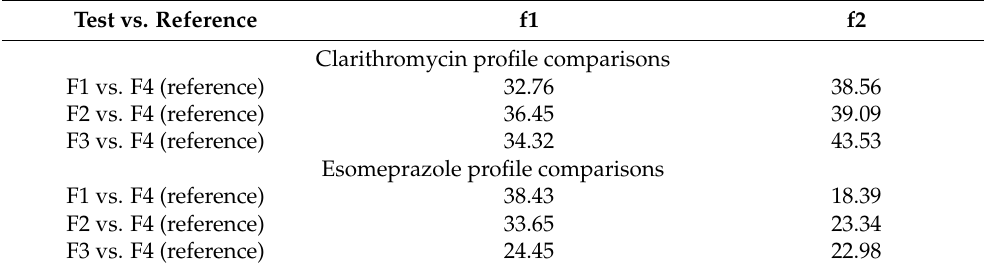
Table 7. Dissolution patterns comparisons.